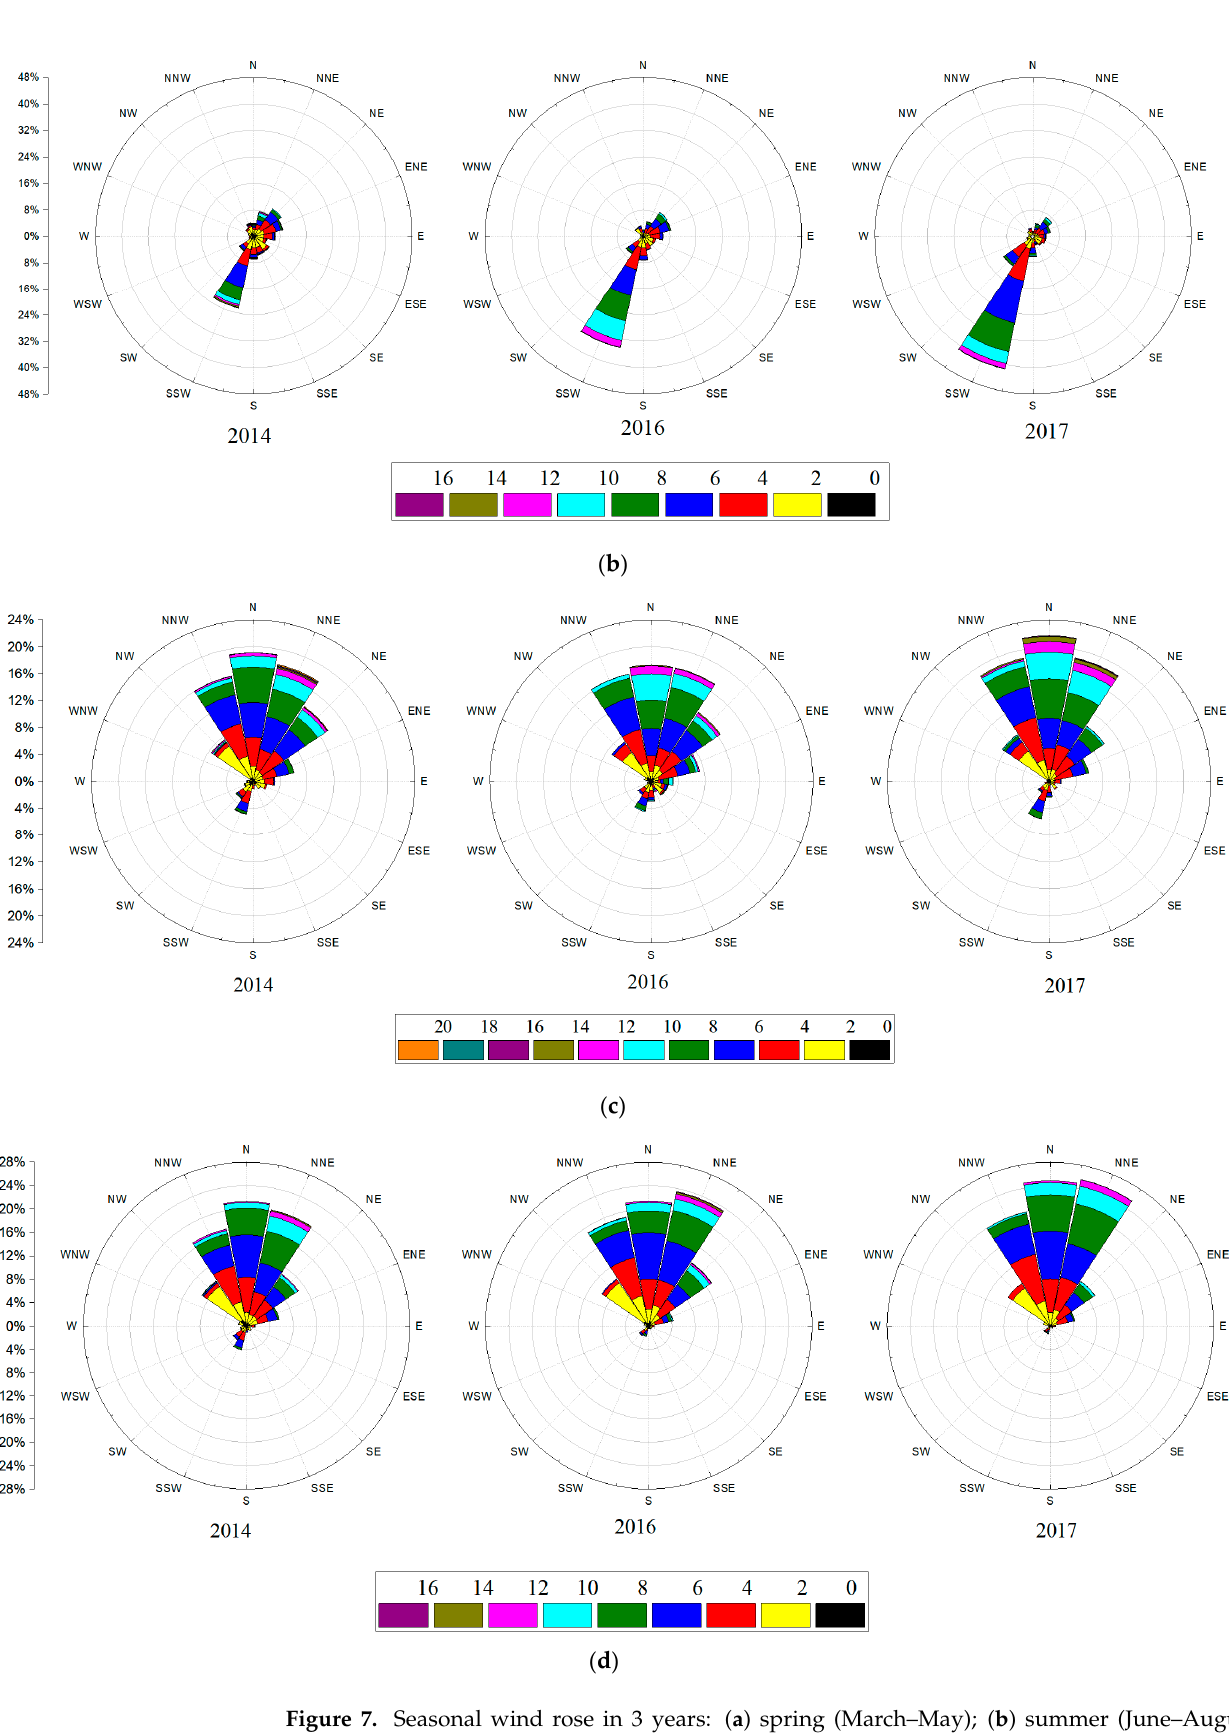
Figure 7. Seasonal wind rose in 3 years: ( a ) spring (March–May); ( b ) summer (June–August); ( c ) autumn (September–November); ( d ) winter (December–February).